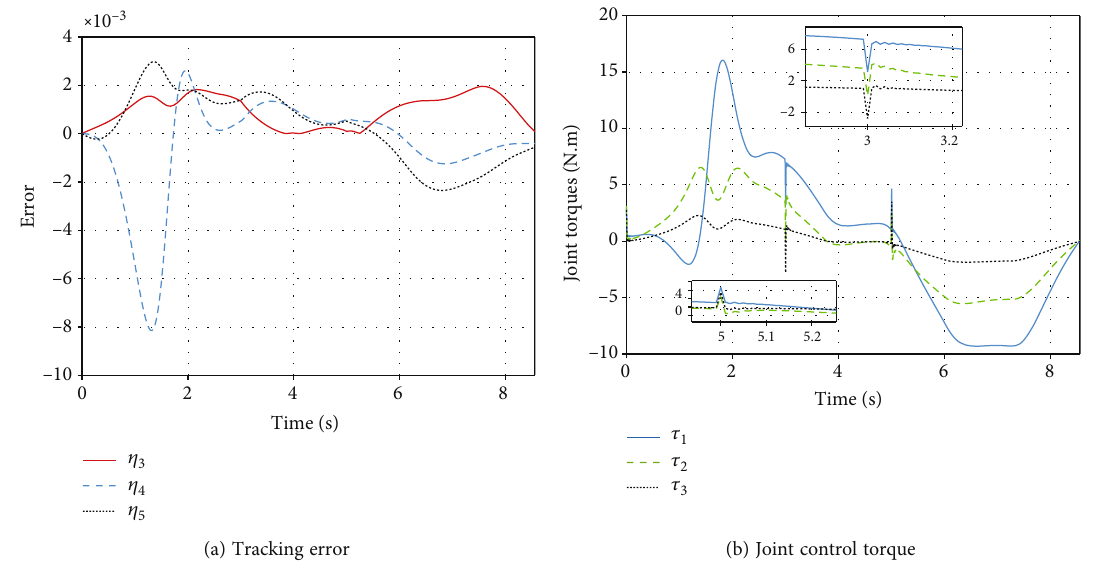
Figure 14: Simulation results of robust fuzzy sliding mode controller with pulse interference